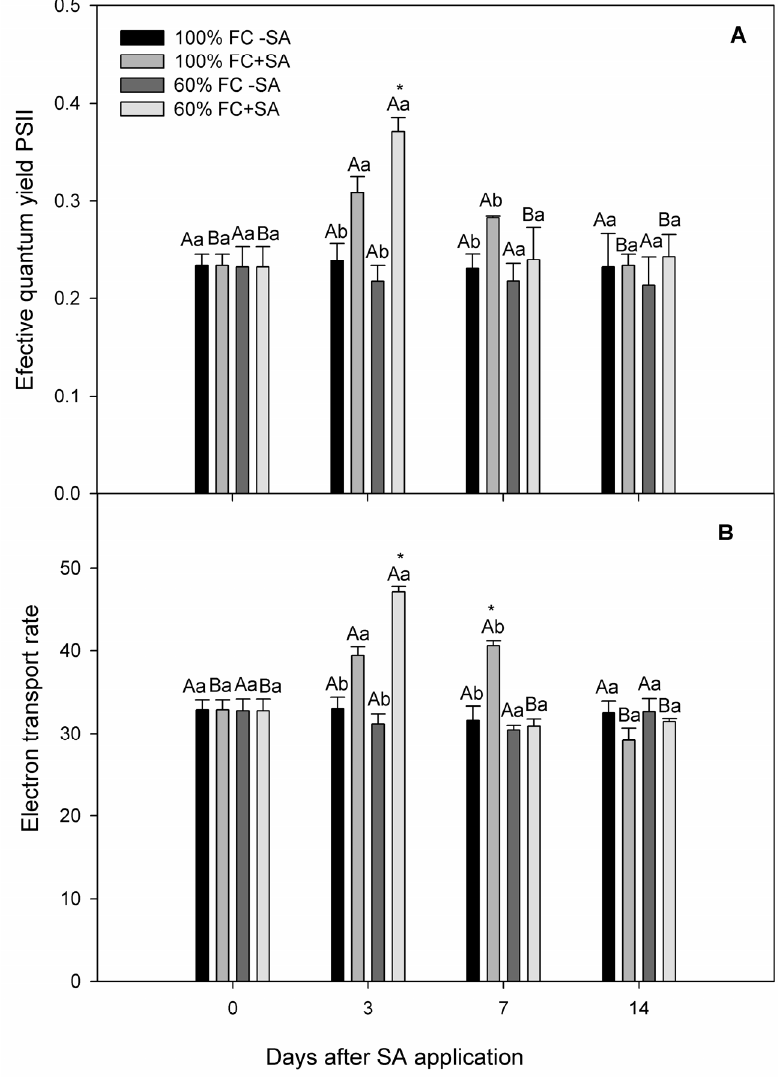
Figure 2. Photochemical parameters in A. chilensis plants grown under 100% and 60% FC and two SA doses (0 and 0.5 mM) at different times. ( A ) effective quantum yield ( Φ PSII) and ( B ) electron transport rate (ETR). The bars are means ± SE ( n = 3). Different uppercase letters indicate significant differences among days for the same SA and irrigation treatment according to Tukey’s test ( p ≤ 0.05). Different lowercase letters indicate significant differences between SA treatment for the same irrigation treatment and time post SA application according to Tukey’s test ( p ≤ 0.05). According to Tukey’s test, asterisks indicate significant differences between irrigation treatments of the experiment for the same SA treatment and time post SA application ( p ≤ 0.05).